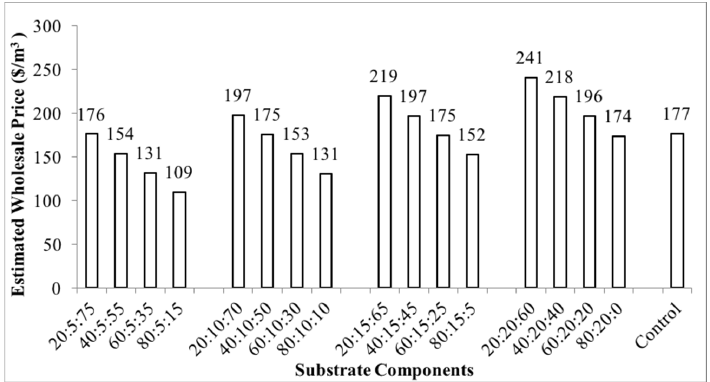
Figure 2. The estimated wholesale price ($) for the 17 formulated substrates per cubic meter. The ratios on the X -axis indicate the percentage ratio of biochar to vermicompost to commercial substrate (by volume). The control was 100% commercial substrate (Berger BM7 35BKS). Table 1. Nutrient analysis of the commercial substrate (CS, Berger BM7 35BKS), biochar (BC), and vermicompost (VC).